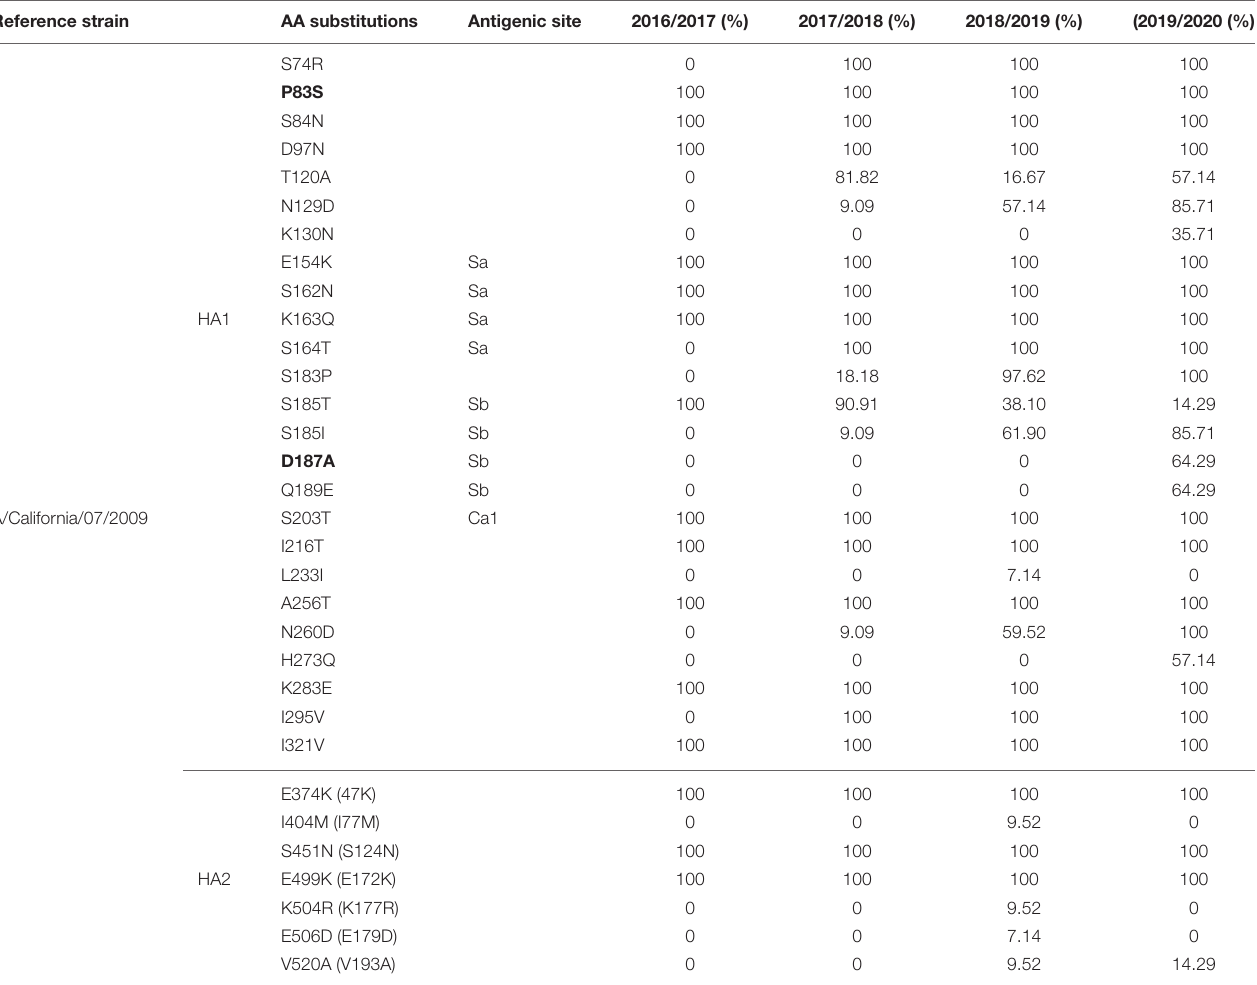
TABLE 4 | Amino acid substitutions identified in HAs of AH1N1pdm viruses sequenced from 2016 to 2020 influenza seasons (without signal peptide). Reference strain AA